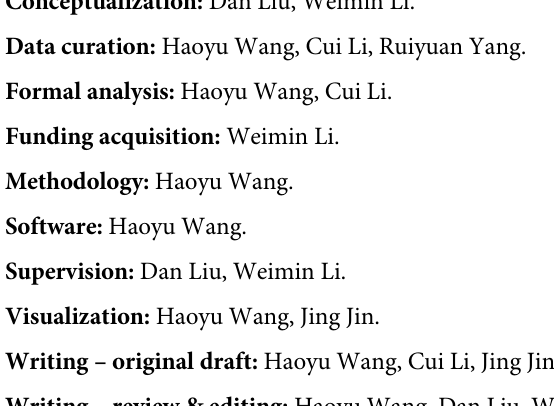
S1 Fig. The forest plot of the association between pretreatment PLR and the survival of lung cancer patients receiving immunotherapy after revoing the potential source of het- erogeneity. a) forest plot for OS; b) forest plot for PFS. (TIF) S1 File. Search strategy for meta-analysis (PubMed via NLM). (DOCX) S2 File. The minimal dataset necessary to replicate our findings.